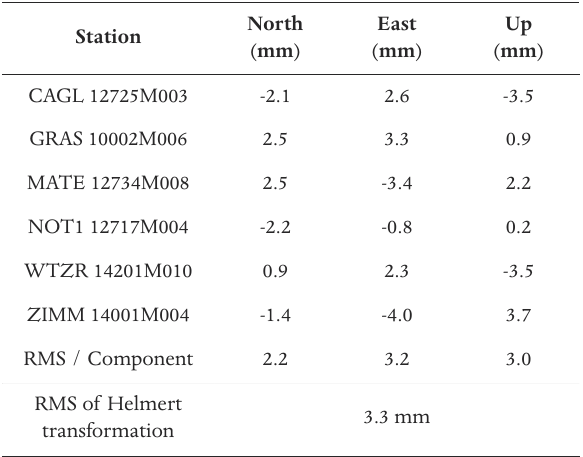
Table 2. Residuals from Helmert transformation between IGS08 and our solution for the reference